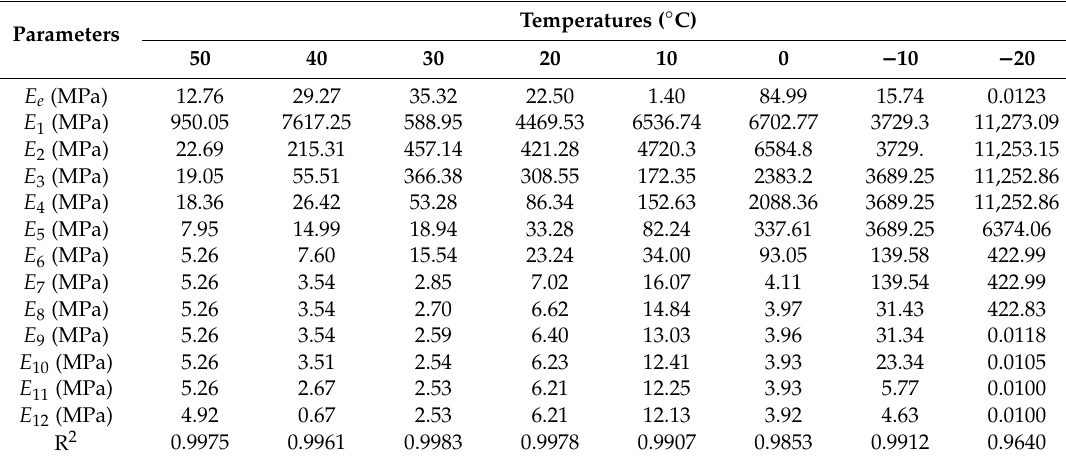
Table 11. The fitting parameters of SBSAM based on the generalized Maxwell